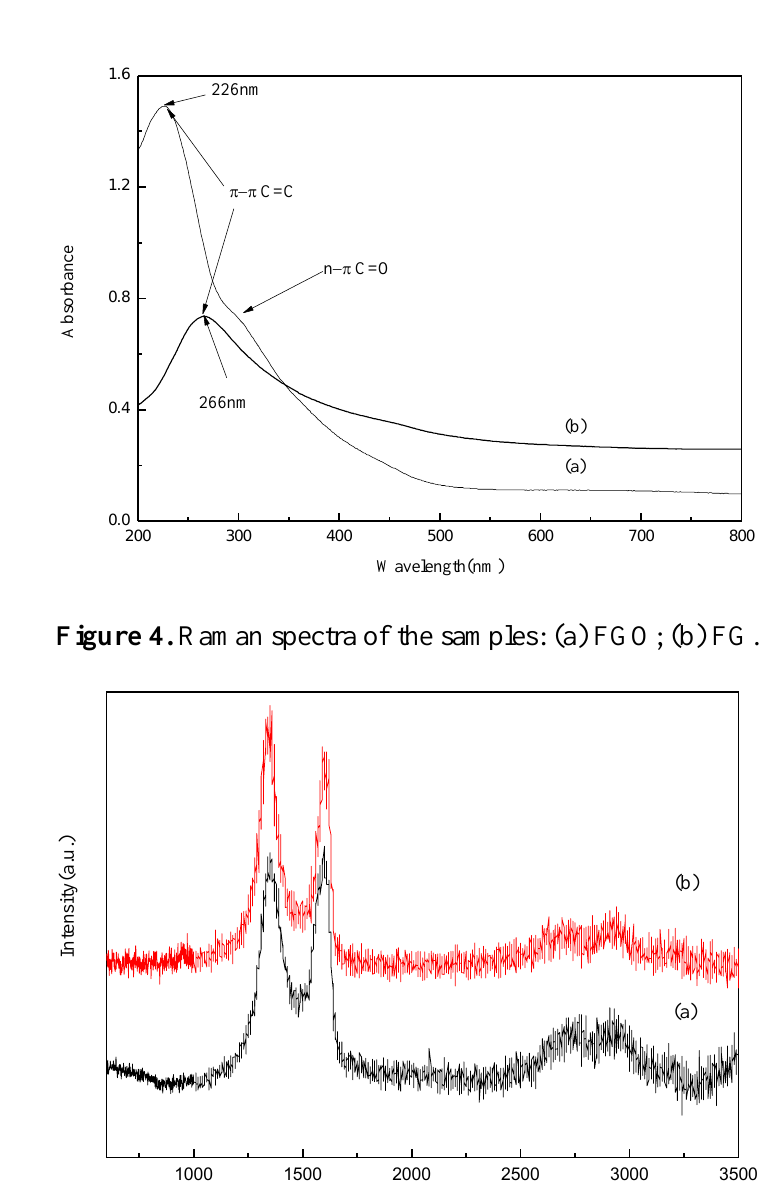
Figure 3. UV-vis spectra of (a) the FGO prepared via two step exploitation of graphite and (b) FG.